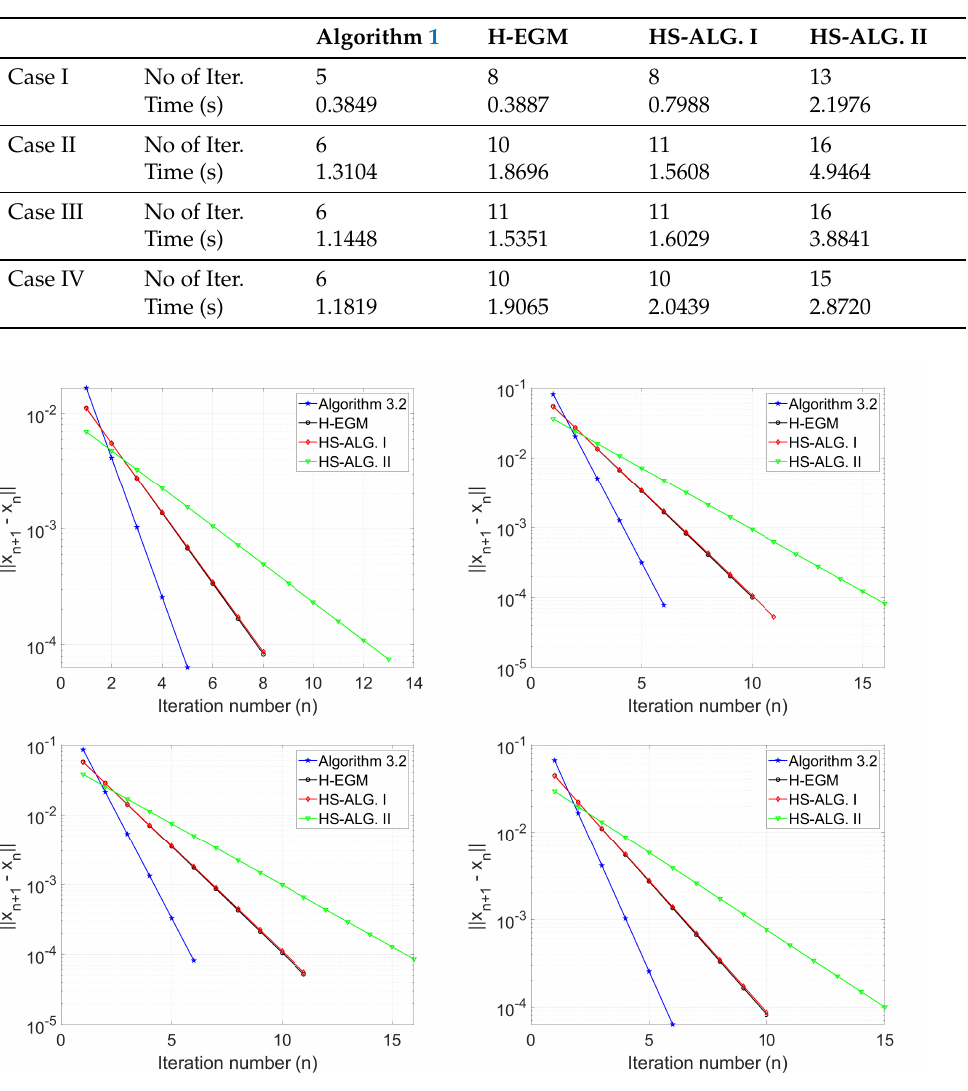
Figure 3. Example 1, Top Left: Case I; Top Right: Case II; Bottom Left: Case III; Bottom Right: Case